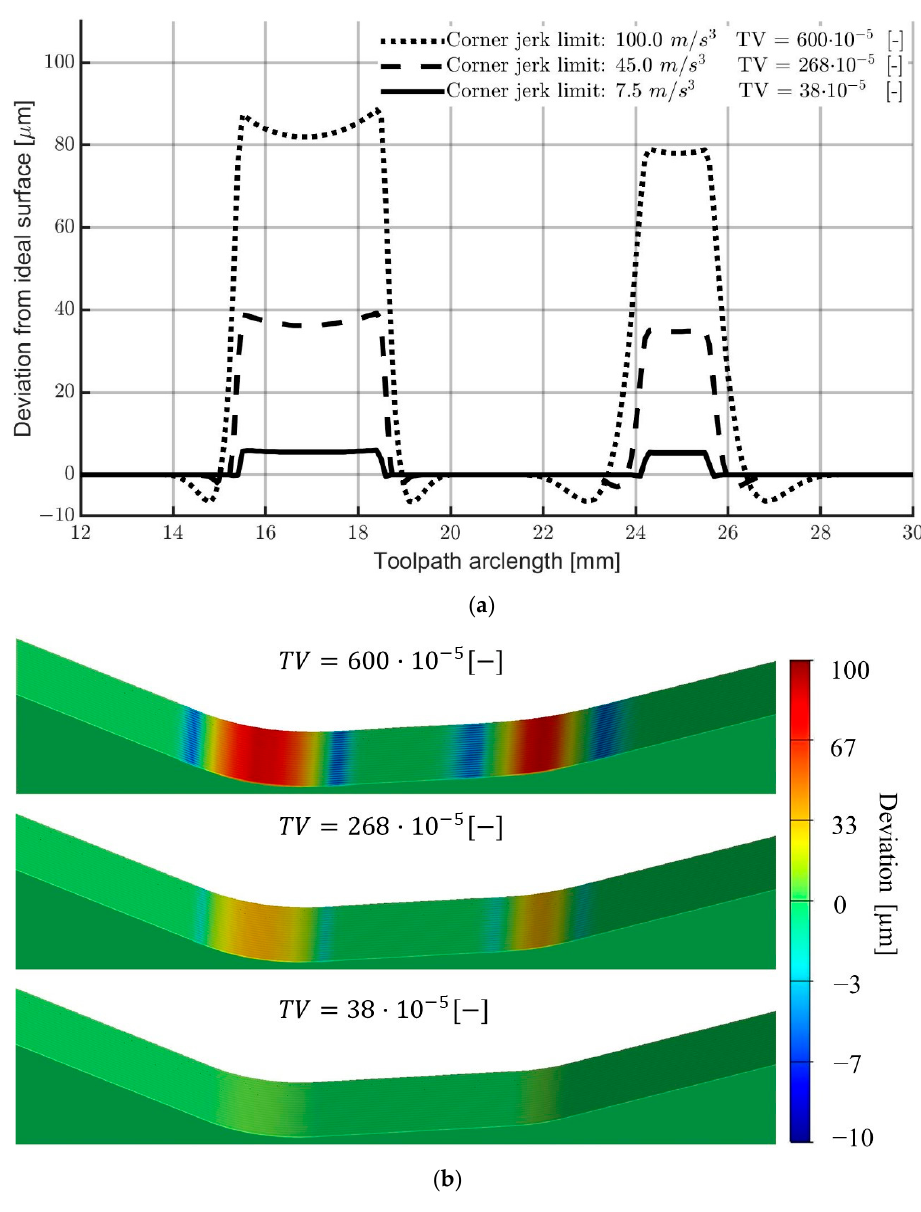
Figure 11. A visualization of the effect of the corner jerk on the deviation error distribution in corner neighborhoods (Valley toolpath). Both figures show a comparison of three corner jerk settings (corner jerk values 7.5, 45, and 100 m/s 3 ) at the limit frequency of 25 Hz, the axis jerk of 45 m/s 3 , and the tolerance limit of 100 µm leading to increasingly larger values of the TV parameter: ( a ) Deviation from ideal surface as a function of toolpath arclength; a comparison of the three cases. ( b ) Deviations of the workpiece surface from the ideal surface visualized using material removal simulation. The visualizations are ordered from the highest TV value (top) to the lowest TV value (bottom).